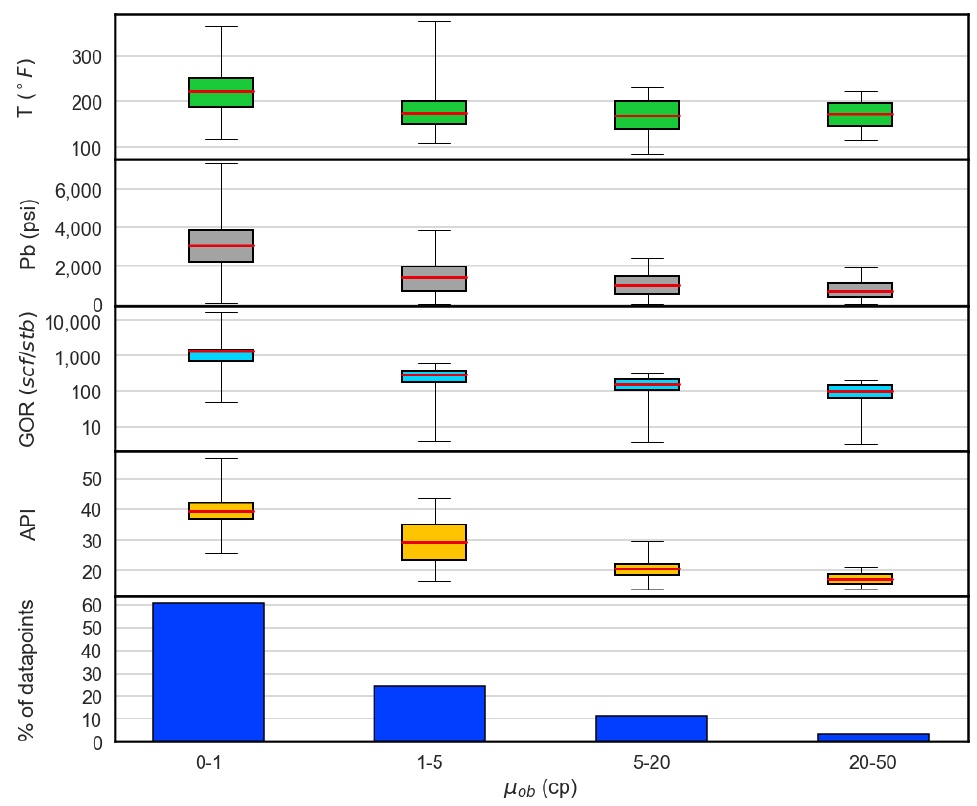
Figure 3. Fluid property values box plots for four viscosity value